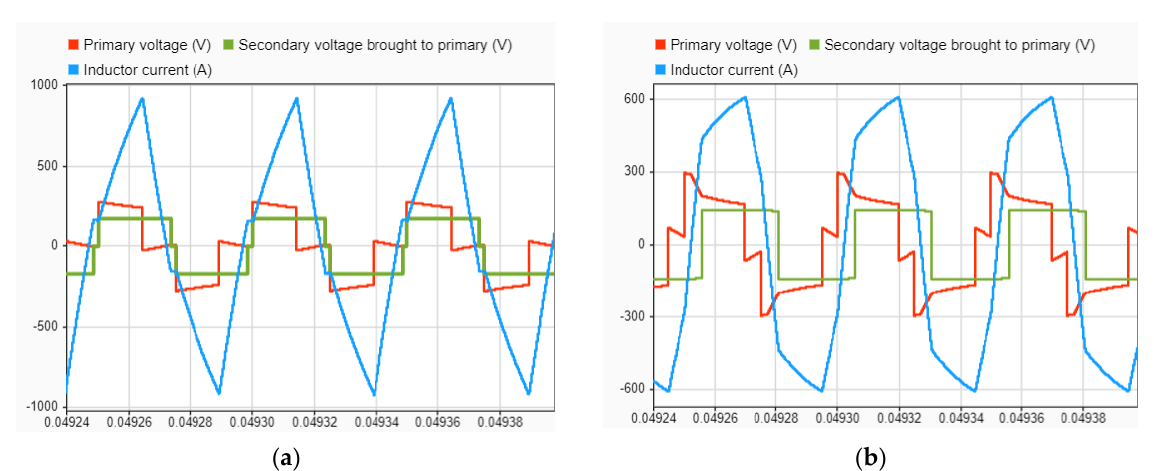
Figure 20. Primary voltage, secondary voltage brought to the primary, and inductor currents for 80 kW DAB DC-DC converter: ( a ) operation under optimal TrgPS; ( b ) operation under optimal EPS.